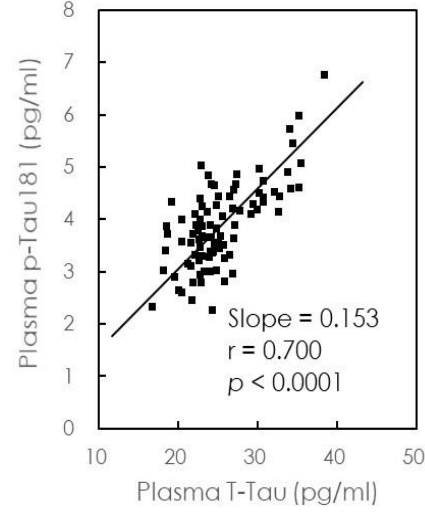
Figure 3. Relationship between plasma levels of p-Tau181 and t-Tau for all participants in the cross-sectional study. 116